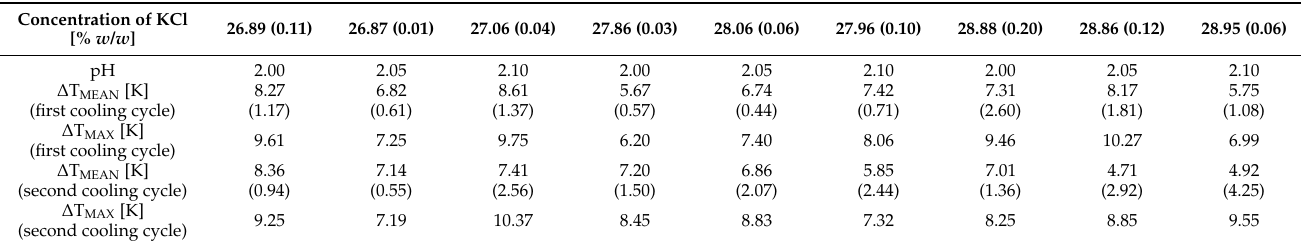
Figure 8. Nucleation point temperatures for the second cooling cycle. Table 2. Metastable zone width in the presence of PAA (values in brackets represent standard